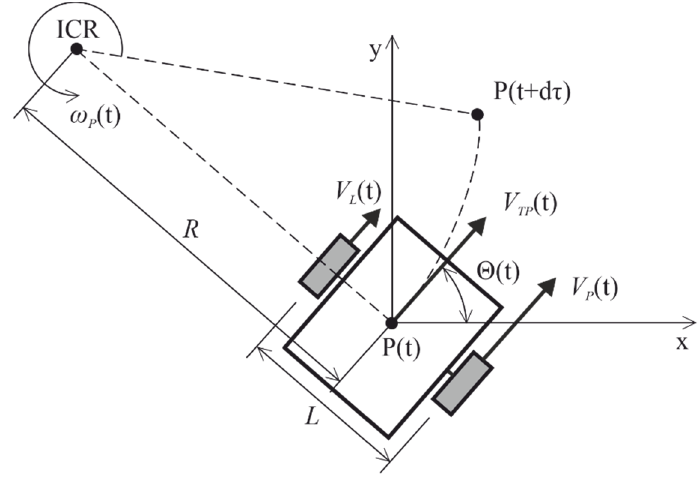
Figure 1. Principal scheme of differential chassis.